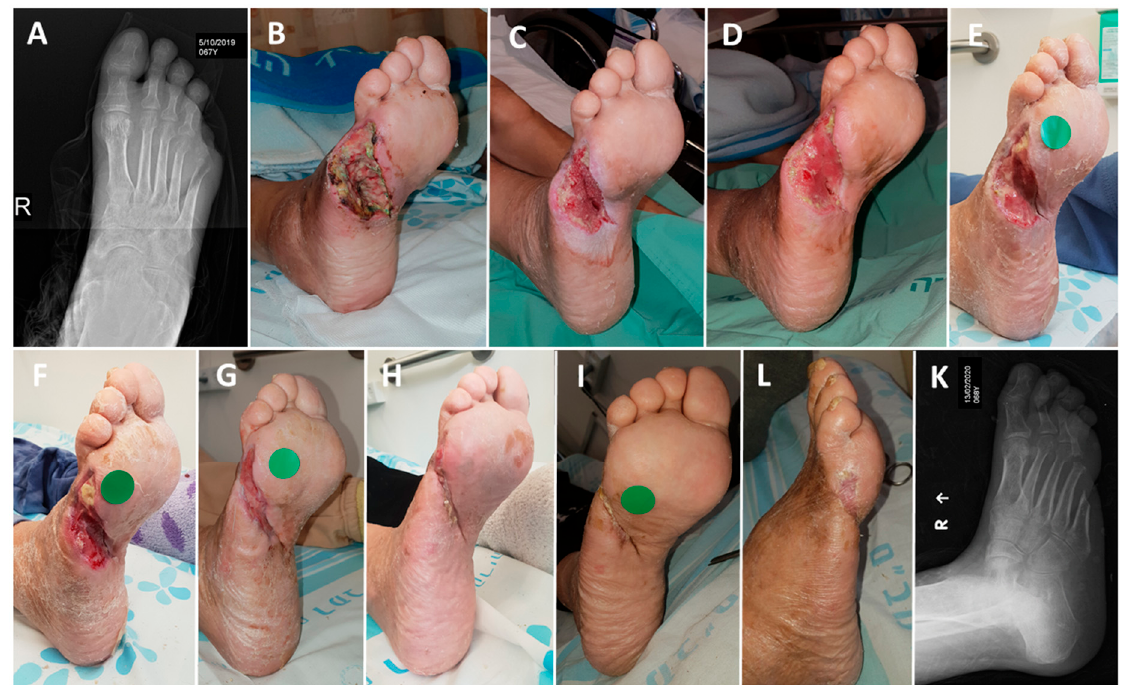
Figure 5. Closure of a wound in a NIDDM patient (Case Report 3) . ( A , B ) The patient underwent right-leg fifth toe ampu- tation due to osteomyelitis and continued infection on October 17 2019. ( C ) After 20 days of SOC including 10 VAC ses- sions, the patient was discharged home on November 7th and the wound was covered with the COD. ( D ) Two days of COD treatment. ( E ) Ten days of COD treatment. ( F ) Seventeen days of COD treatment . ( G ) Thirty-one days of COD treat- ment. ( H ) Fifty-five days of COD treatment. ( I ) After 77 days of COD treatment the wound was completely closed and the COD treatment was stopped. ( L , K ) The wound remained solidly closed 20 days after wound